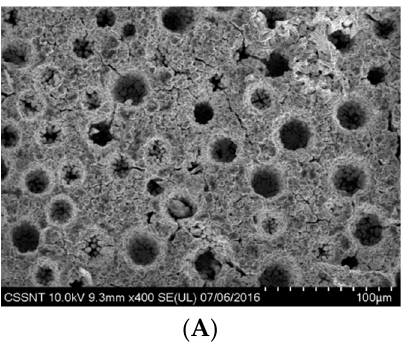
Figure 1. SEM micrographs at di ff erent magnifications for electrodeposited Ni f (1 A / cm 2 , 3 min.) onto Figure 1 . SEM micrographs at different magnifications for electrodeposited Ni f (1 A/cm 2 , 3 min.) onto Cu metallic substrate. ( A ) × 400, ( B ) × Cu metallic substrate. ( A ) × 400, ( B ) × 8000.